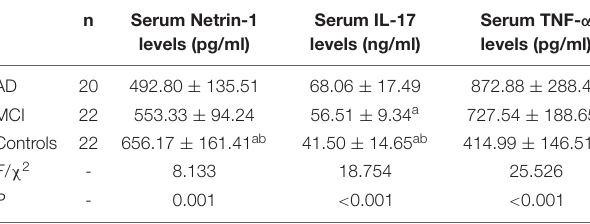
TABLE 2 | Clinical features of the study